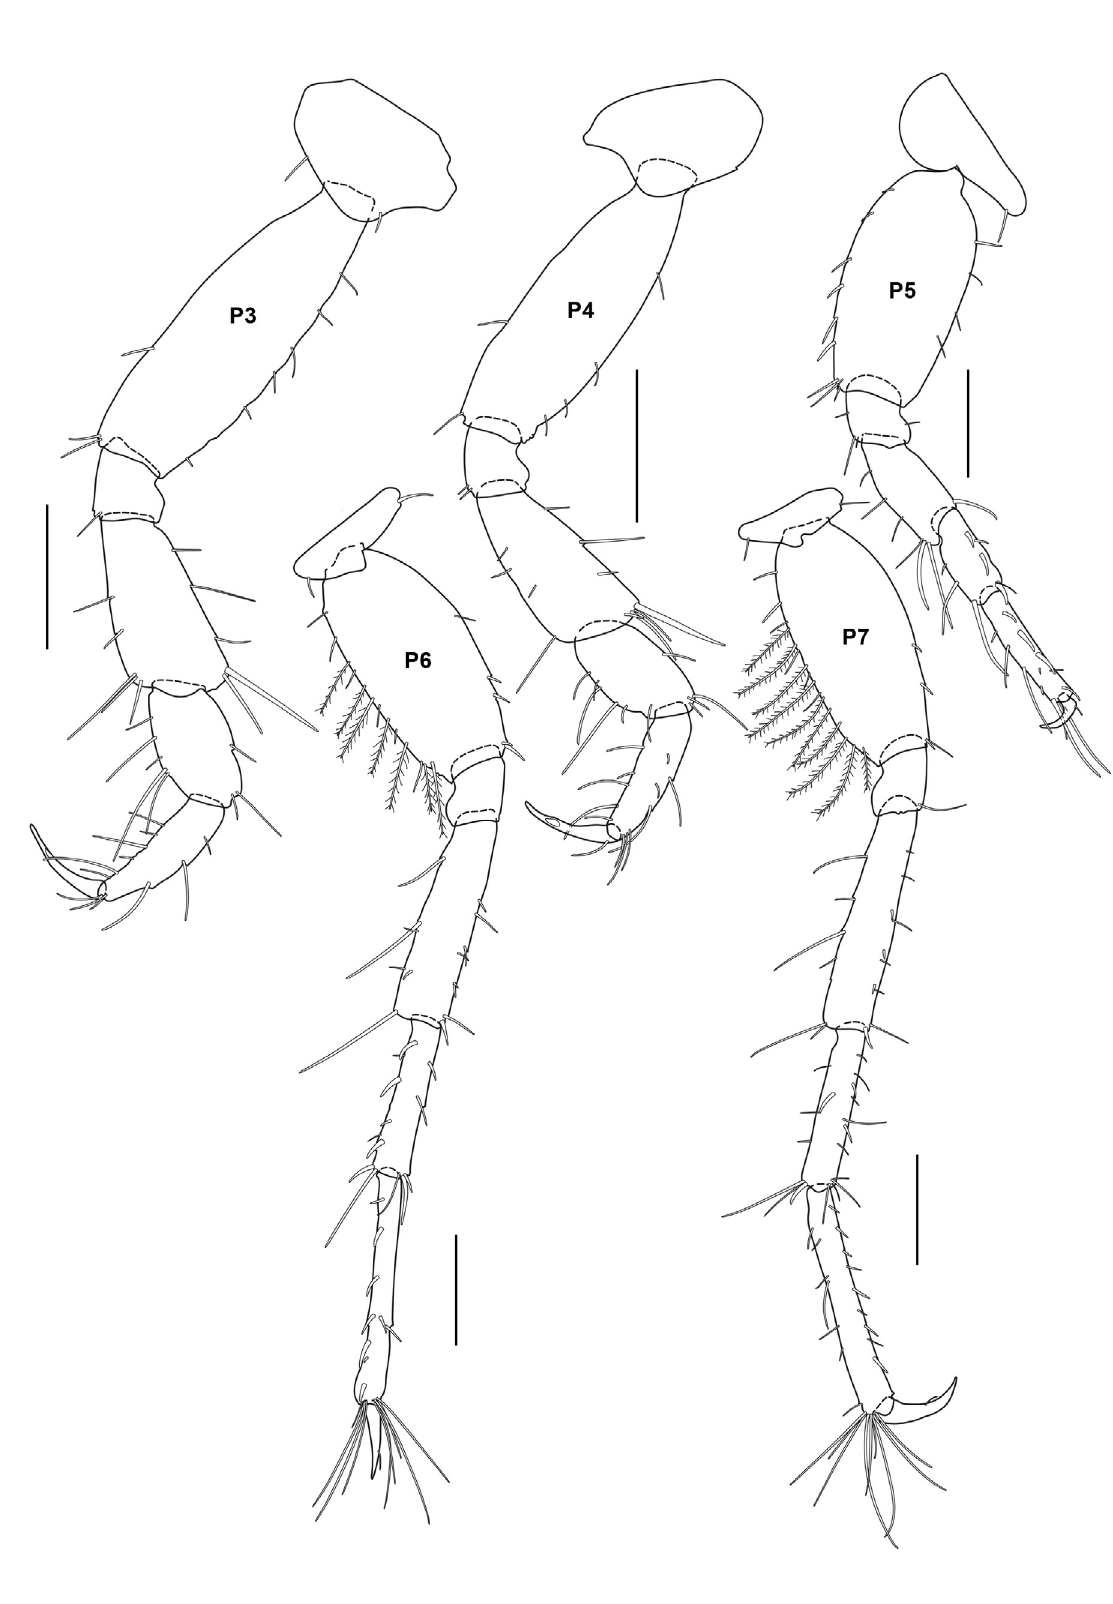
Fig. 5. Grandidierella pawaiensis sp. nov., holotype, ♂ (ZRC 2018.0493). Scale bars: 0.25